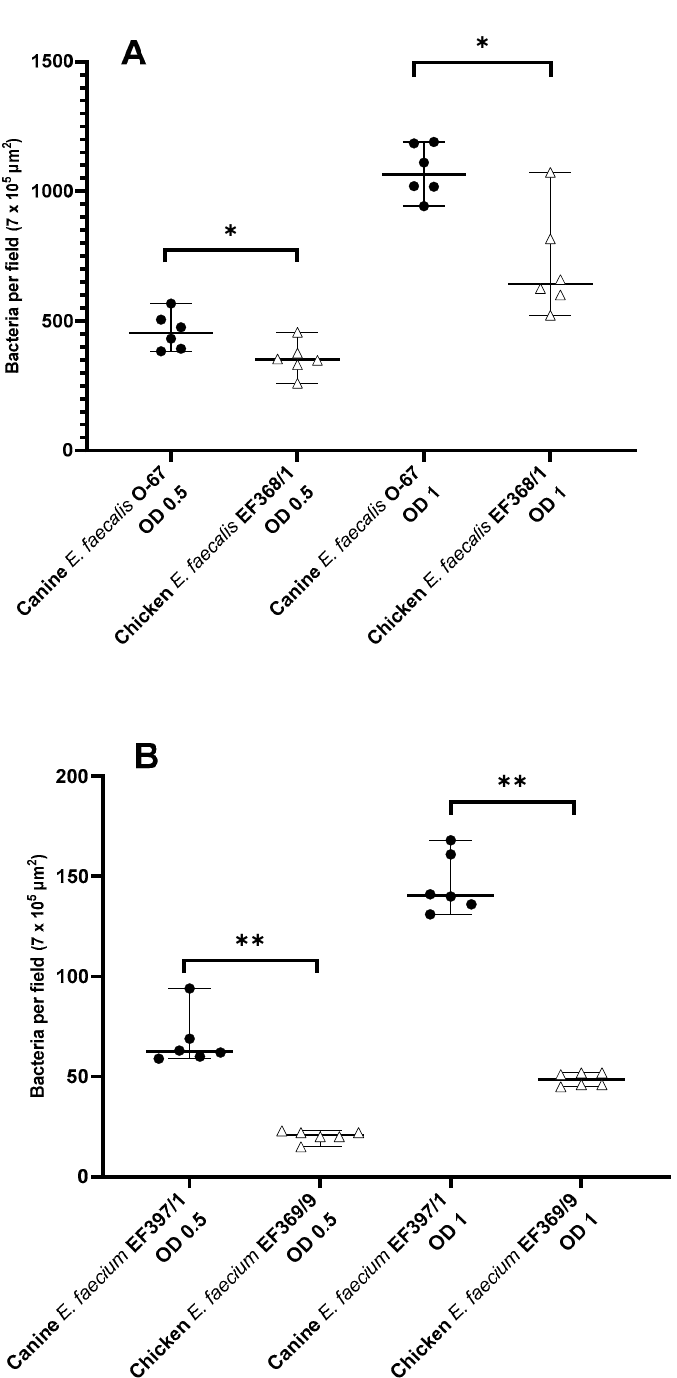
Figure 3. Scatter plot displaying the adherence of canine- and chicken-derived E. faecalis ( A ) and E. faecium ( B ) to the duodenal mucosa of healthy beagles. Data are expressed as the median with range. OD, optical density at 600 nm; * p < 0.05, ** p < 0.01. The hydrophobicity level for canine E. faecalis O-67 was medium (36.6%) and low for chicken E. faecalis EF368/1 (20.4%), canine E. faecium EF397/1 (5.7%), and chicken E. faecium EF369/9 (4.5%) (Figure